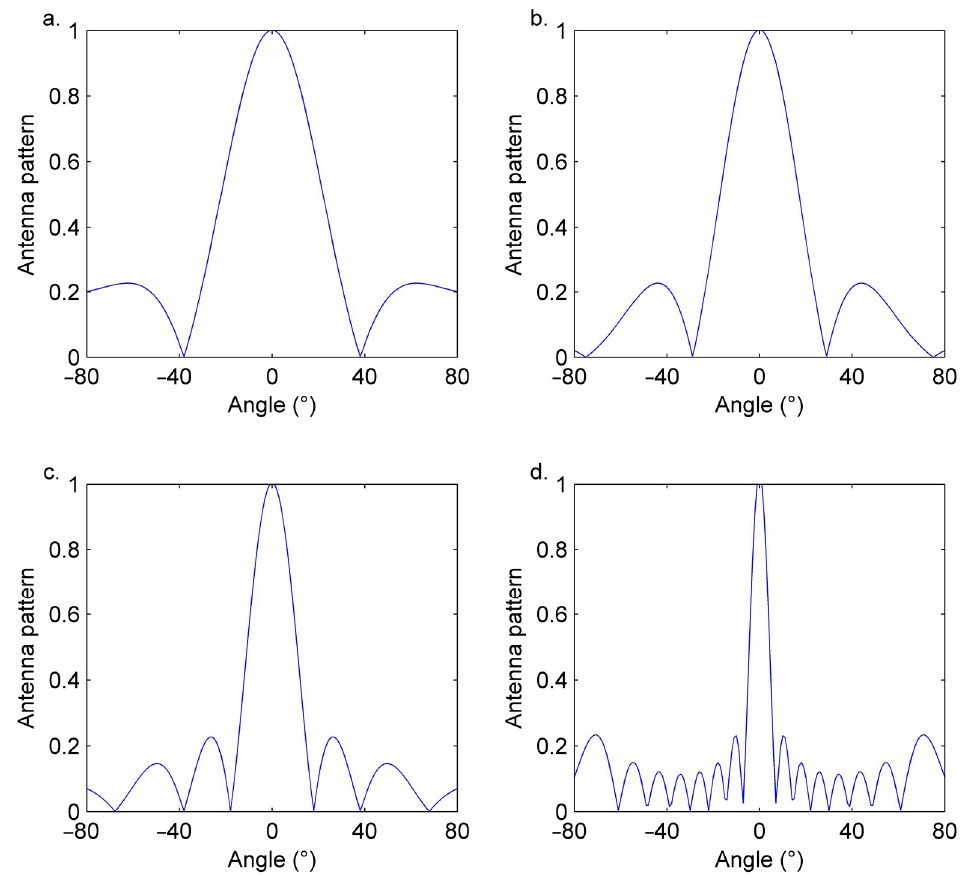
Figure 9. The antenna pattern simulations at di ff erent frequencies. ( a ) 10.8 GHz; ( b ) 18.7 GHz; ( c ) 23.8; ( d ) 36.5